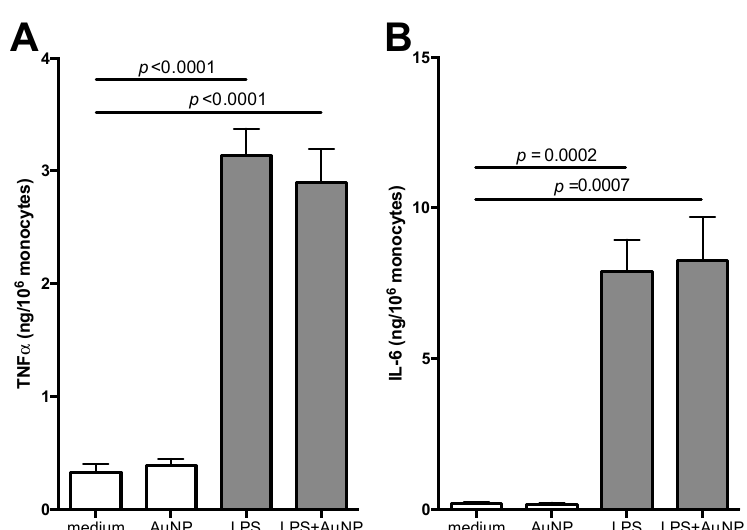
Figure 3. Primary response of human monocytes to LPS and AuNP . CD14 + monocytes were exposed for 24 h to LPS (1 ng/mL) in the absence or in the presence of AuNP (10 μ g/mL). Release of TNF α ( A ) and IL-6 ( B ) was measured in the supernatants. Results are reported as mean ± SEM of data from 4 individual donors, tested in four separate experiments. p values are indicated when p < 0.05. Although statistically significant, we have not reported in the figure the differences between AuNP and LPS ( p < 0.0001 for TNF α , and p = 0.0002 for IL-6) or between AuNP and LPS + AuNP ( p < 0.0001 for TNF α , and p = 0.0007 for IL-6).